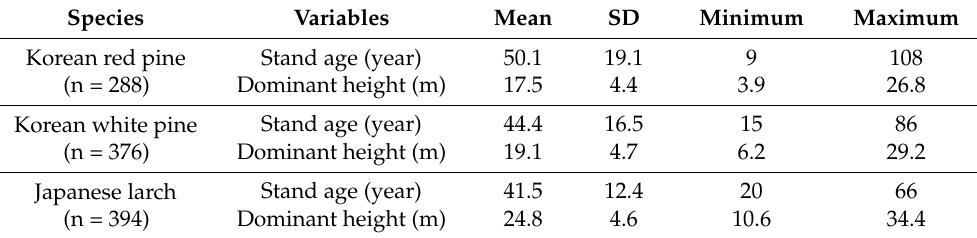
Table 1. Summary statistics of the modeling data to develop the dominant height and site index models by species. n: the number of samples. SD: standard